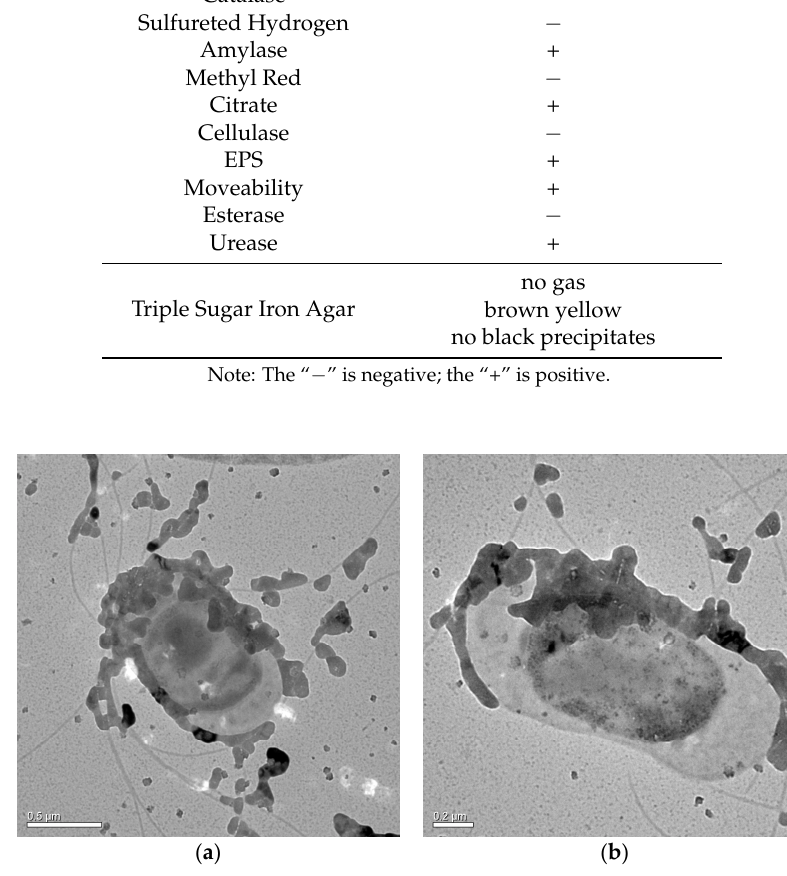
Figure 1. The morphology of LD532 bacteria analyzed by HRTEM.